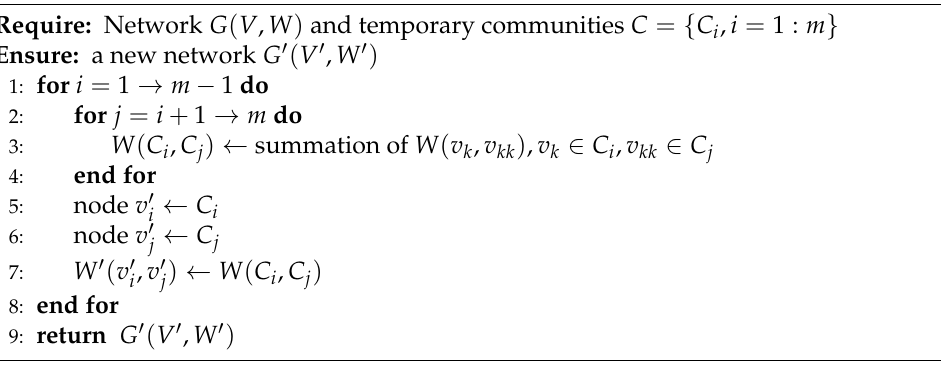
Algorithm 2 Construction of a new